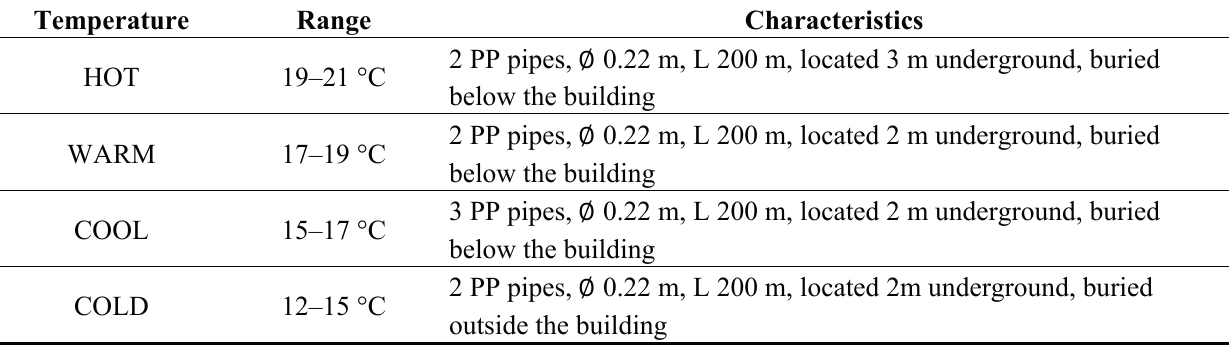
Table 1. Linguistic terms associated to temperature ranges for the different zones, and pipes